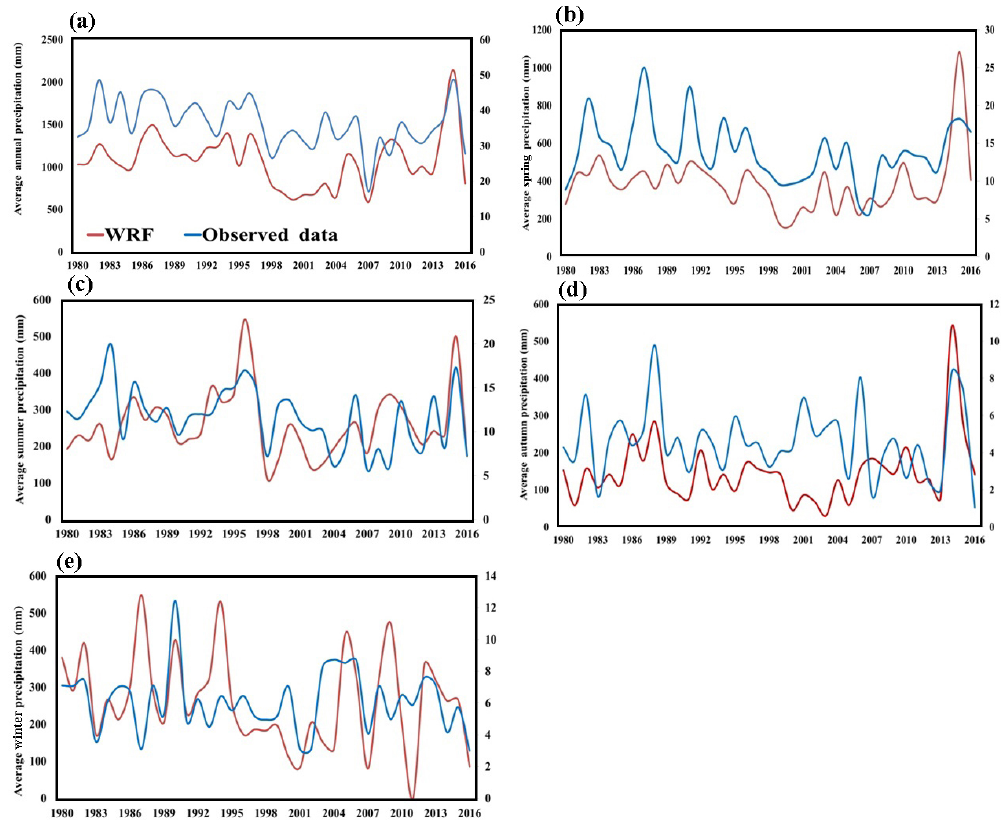
Figure 6. Same as Fig. 5 but for precipitation. Here the minimum and maximum precipitation values are not considered because they cannot be defined properly within a